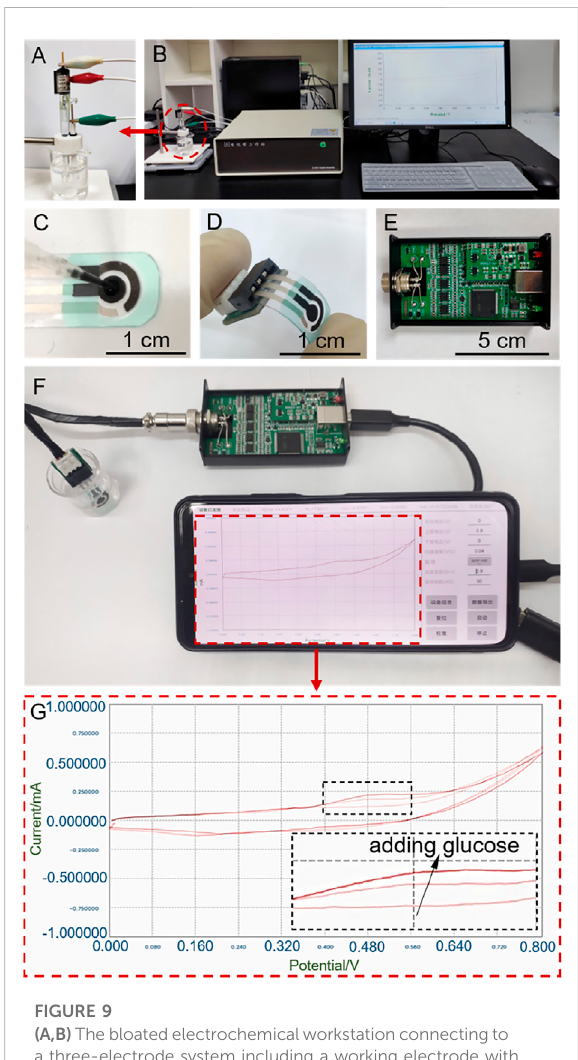
FIGURE 9 (A,B) Thebloatedelectrochemicalworkstationconnectingto a three-electrode system including a working electrode with catalyst, a Pt plate electrode and a saturated calomel electrode. (C,D) Image of the three-electrode chip. (E) Image of the integrated circuit board. (F) Portable and compact electrochemical system including the three-electrode chip, integrated circuit board and mobile phone for recording and displaying the data. (G) CV curves recorded on the electrochemical system shown in ( F